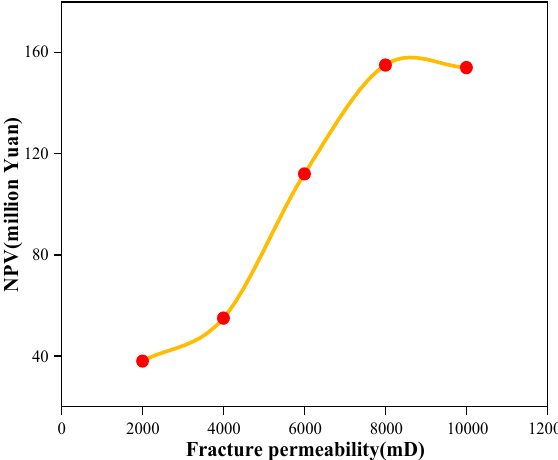
Figure 16. NPV variation with fracture permeability.